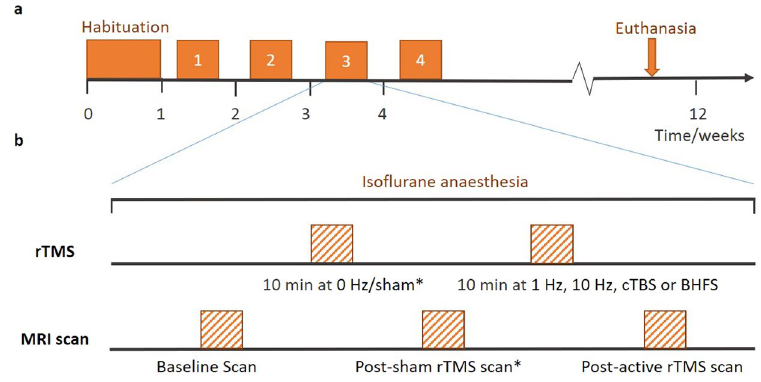
Figure 1. Experimental protocol. ( a ) Timeline for a single rat from the time of its arrival. The experiment consisted of a habituation period followed by four sessions of fMRI-LI-rTMS-fMRI. Sessions one to four were the same, except for the frequency of LI-rTMS used and whether 0 Hz/sham stimulation preceded actual stimulation. ( b ) Protocol for a single LI-rTMS/rs-fMRI session. During each session, baseline rs-fMRI data were acquired after which stimulation using a specific protocol (1 Hz, 10 Hz, BHFS or cTBS) was delivered. A post- procedure rs-fMRI scan was then carried out. * Sham stimulation and post-sham LI-rTMS scan were carried